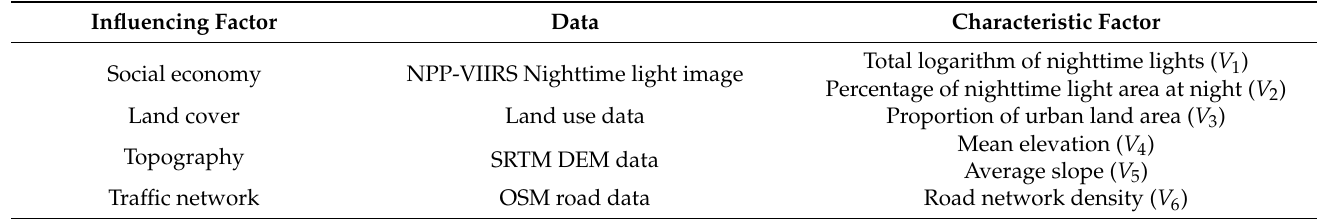
Table 3. Multidimensional factors based on geographic